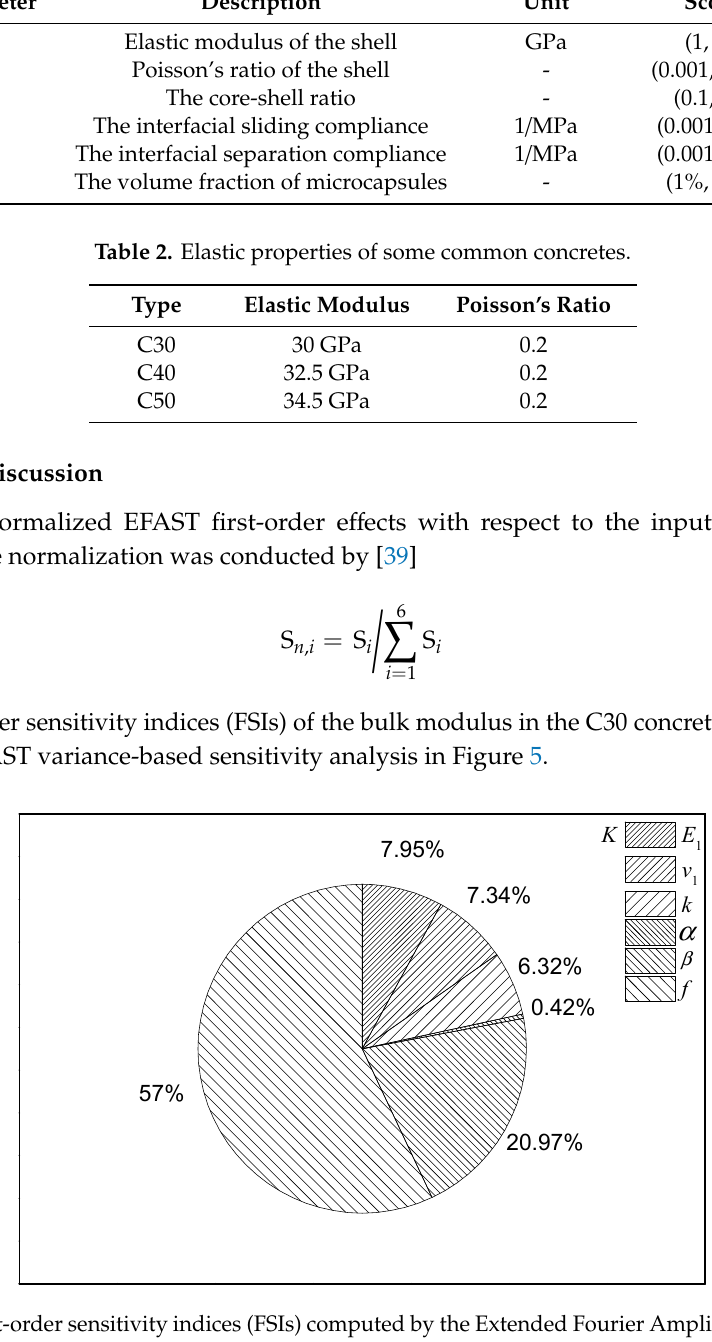
Figure 5. First-order sensitivity indices (FSIs) computed by the Extended Fourier Amplitude Sensitivity Test (EFAST) for the bulk modulus in the C30 concrete.